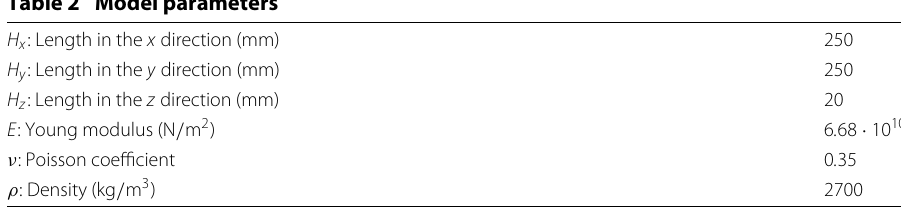
Fig. 12 The elasto-plastic dynamical problem taken into consideration Table 2 Model parameters